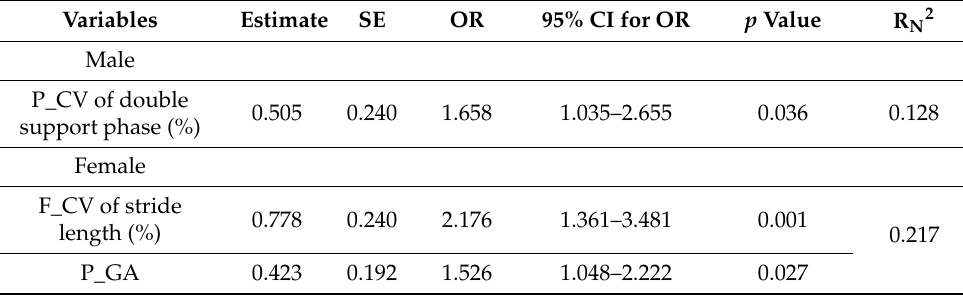
Table 3. Binary logistic regression results for 60–69 years and 70–79